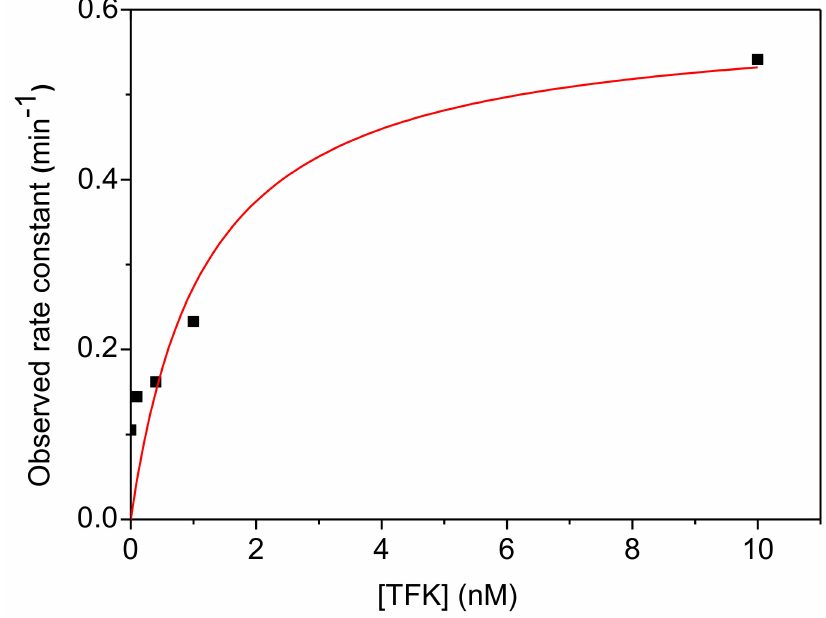
Figure 11. Dependence of k obs,max (fast process, see Equations (7) and (8)) of hAChE phosphorylation by CSP as a function of TFK concentration (after 120 min